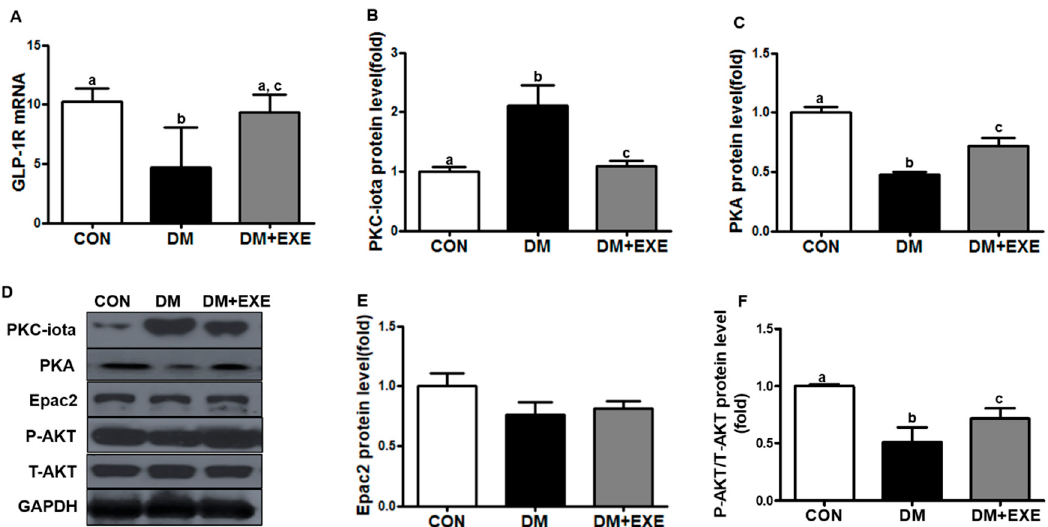
Figure 3. Resistance exercise training inhibited loss of GLP-1R and enhanced signaling pathway in